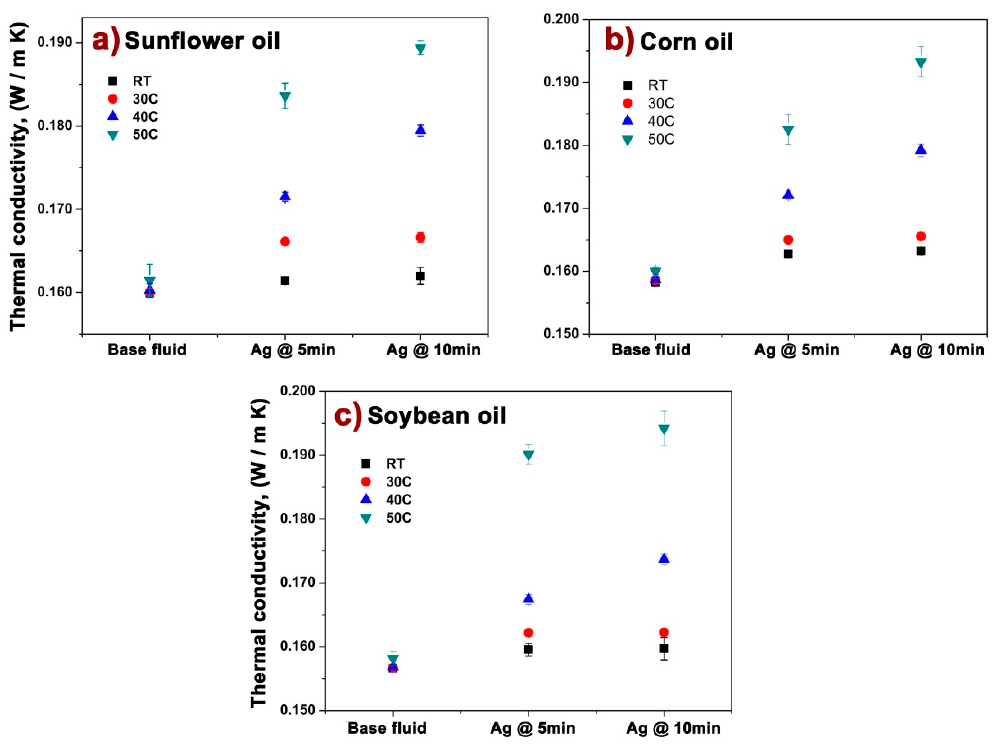
Figure 3. Thermal conductivity enhancement of vegetable nanofluids at 5 and 10 min laser ablation times. ( a ) Sunflower oil, ( b ) Corn oil and ( c ) soybean oil.